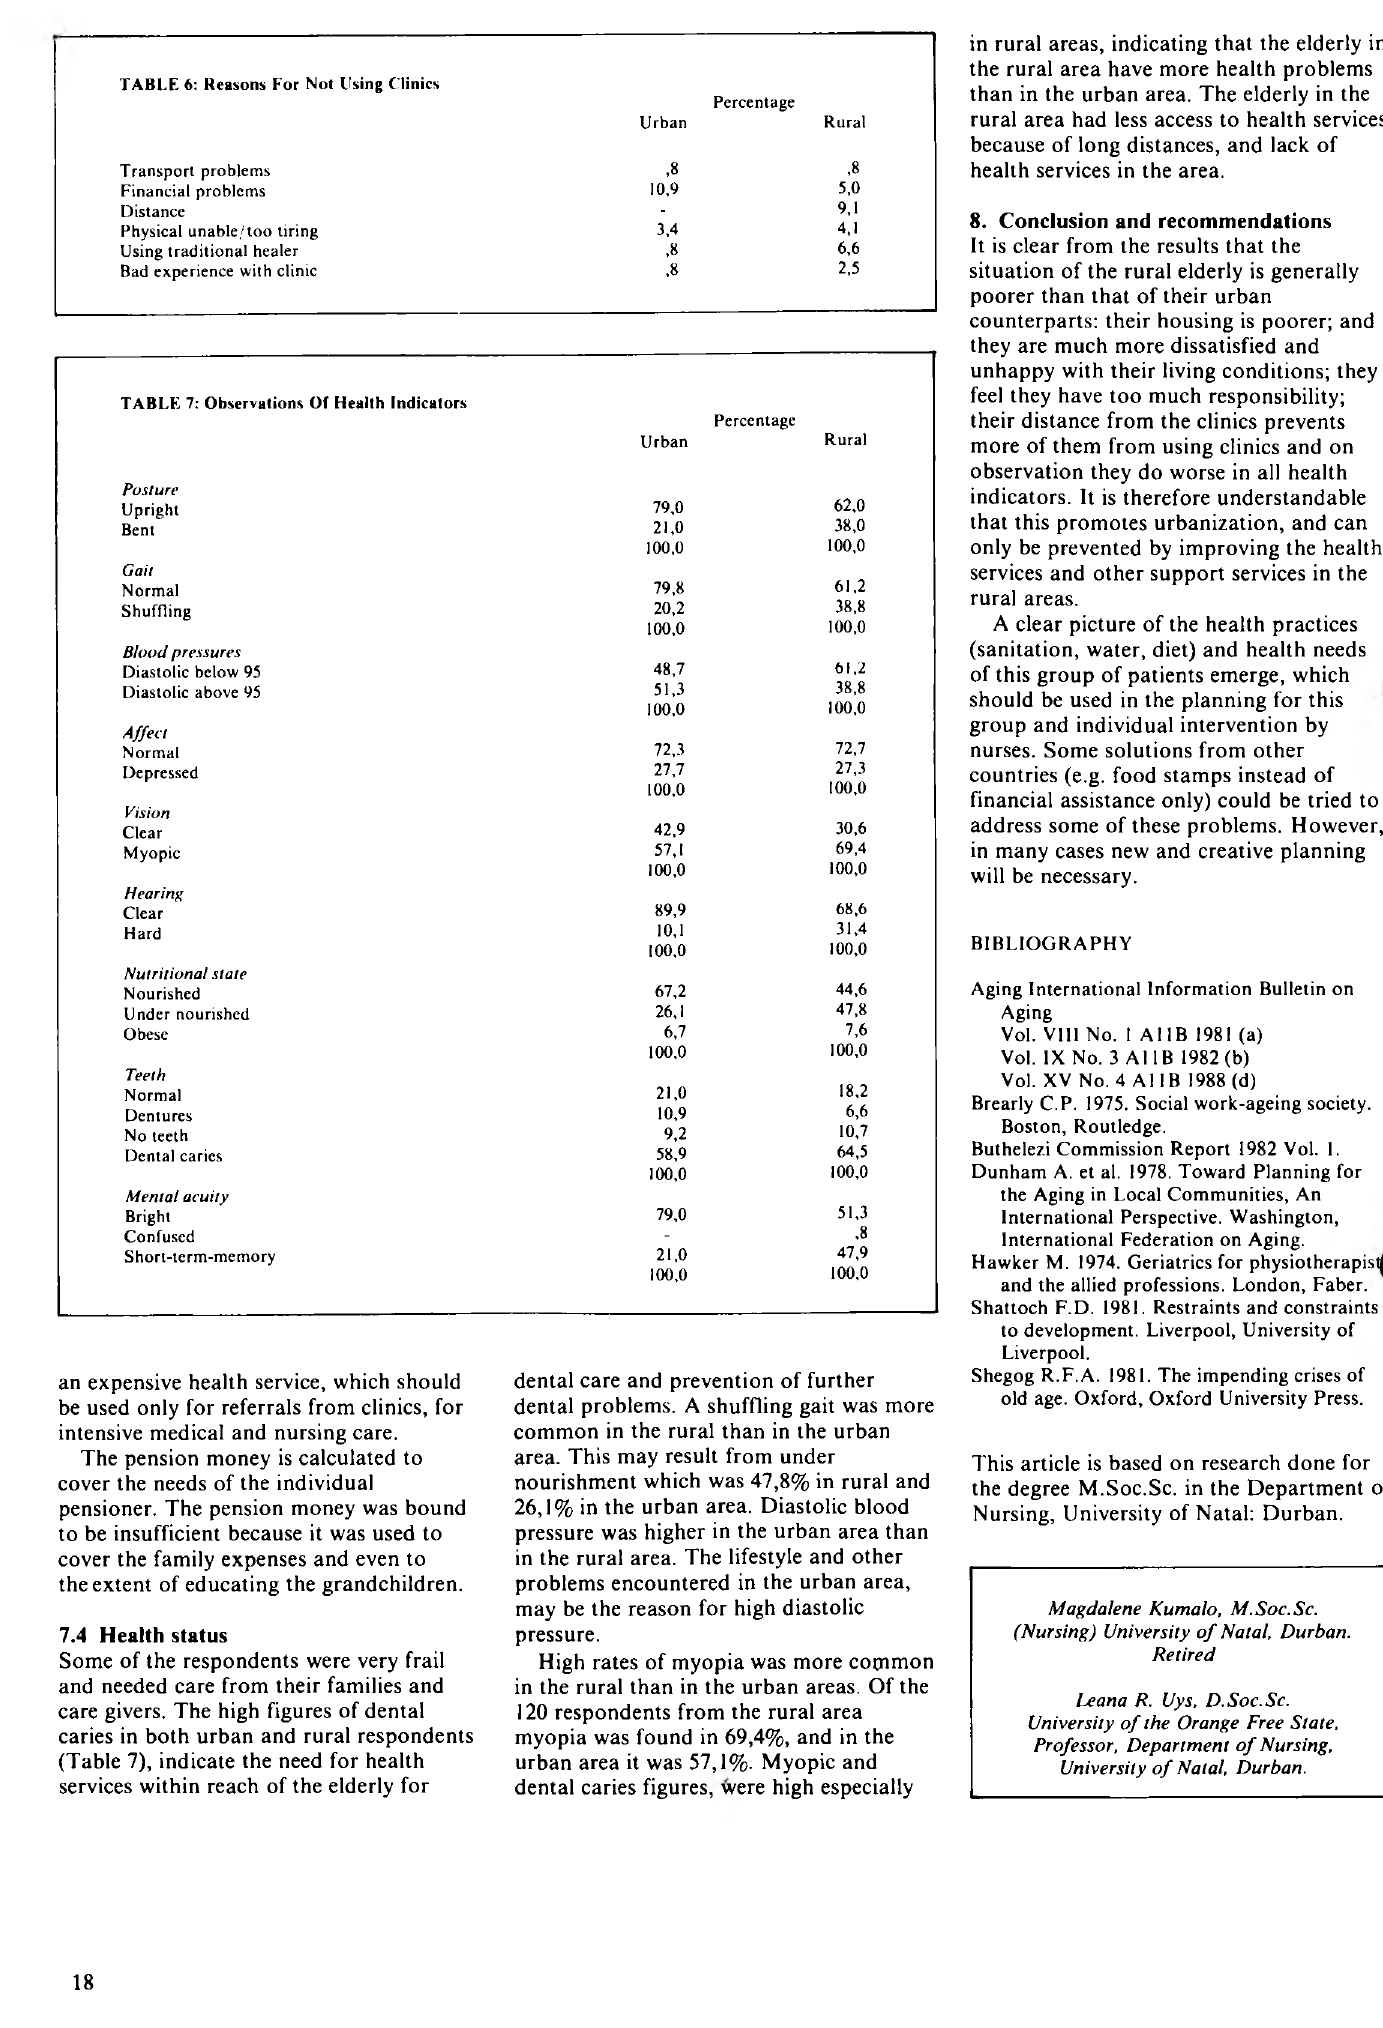
Percentage Urban Rural